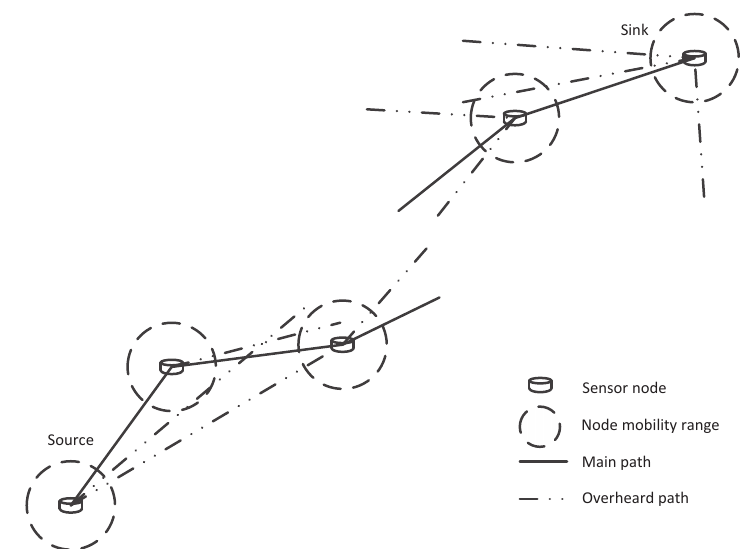
Figure 1. An illustration of network model for underwater acoustic sensor